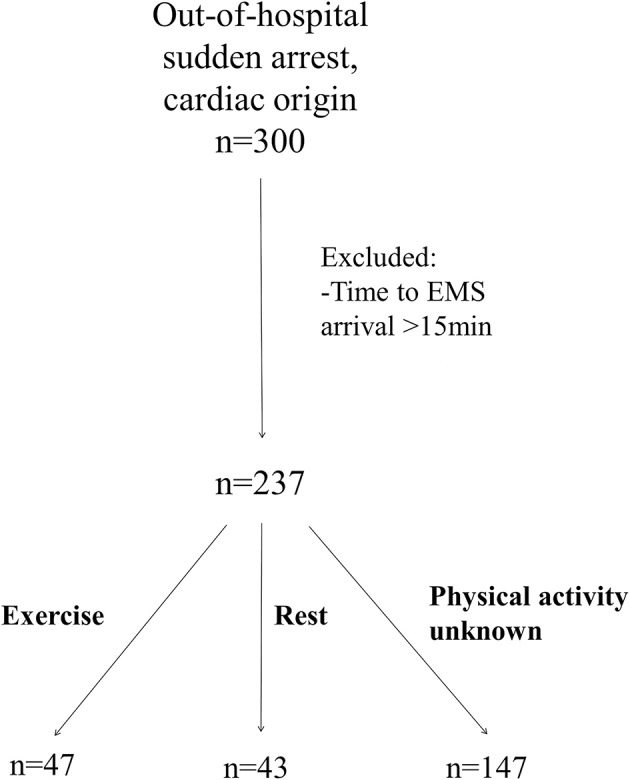
Study populations.